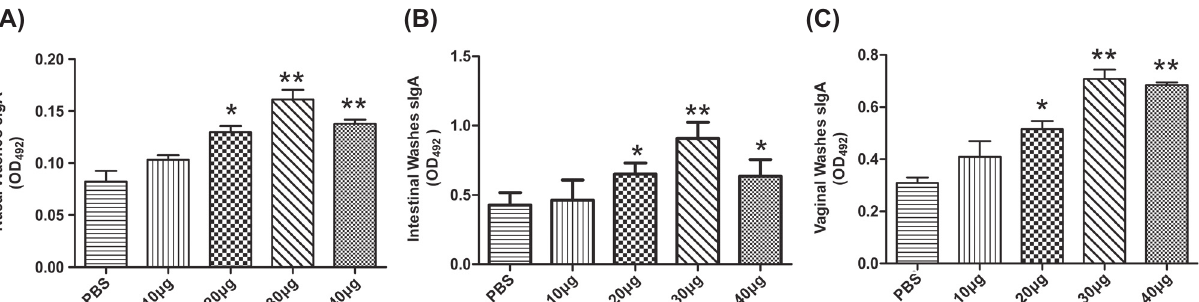
Figure 2. Evaluation of specific sIgA responses in mucosal washes from intranasal vaccinated mice. Groups of BALB/c mice received different doses of rTgPGAM 2 or PBS vaccine on days 0, 14 and 21. Two weeks after the last inoculation, nasal, intestinal and vaginal washes were collected to evaluate sIgA titres by ELISA. The levels of sIgA in nasal washes (A), intestinal washes (B) and vaginal washes (C) were elevated in mice nasally immunised with rTgPGAM 2 compared with vaccination with PBS. The results are expressed as the mean of the OD 492 ± SD ( n = 10) and representative of three experiments. * P < 0.05, ** P < 0.01 (vaccinated vs. PBS